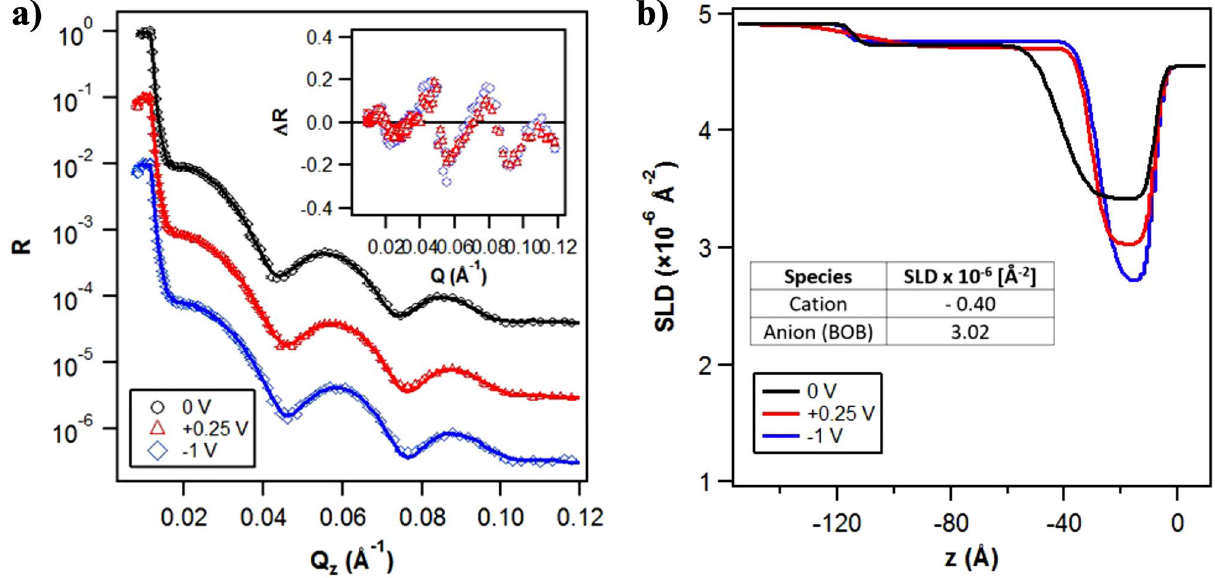
Figure 5. ( a ) NR reflectivity curves for contrast matched 2EHL + 5% P-BOB at different applied potentials. The curves are offset in the Y-axis for clarity. The symbols represent experimental data, whilst the solid lines are best- fits to the data. Inset: Asymmetry plot highlighting the changes in the non-zero potential NR curves with respect to the 0 V curve. ( b ) SLD profiles obtained from the best fits to the NR data (z = 0 at the gold/solution